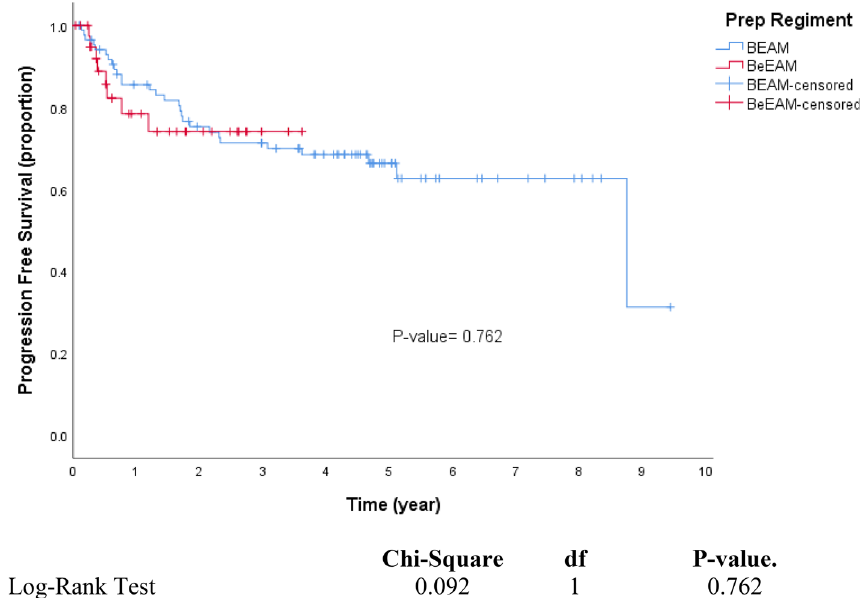
Figure 2. Kaplan–Meier analysis of progression-free survival. Progression-free survival in patients who underwent an ASCT with BEAM or BeEAM. ASCT autologous stem cell transplantation, BEAM BCNU, etoposide, cytarabine, melphalan, BeEAM bendamustine, etoposide, cytarabine, melphalan. p values were determined using the log-rank